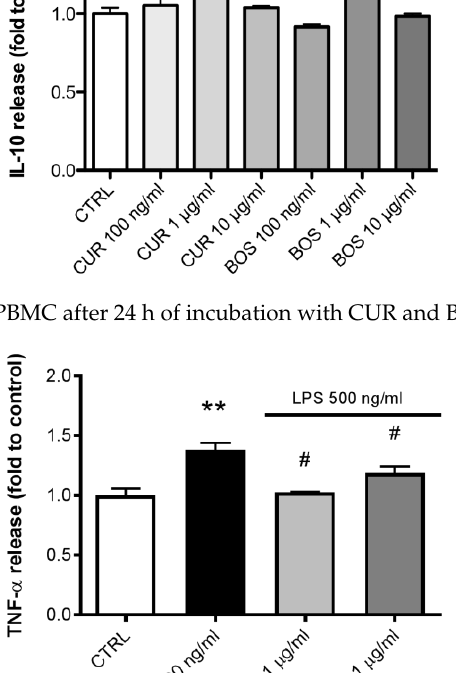
Figure 5. IL-6 release in HMC-1.1 after 24 h of PMA stimulation (50 ng/mL); cells were preincubated with CUR and BOS for 24 h. *** p < 0.001 vs. control; # p < 0.05 vs. stimulus. Neither CUR nor BOS at each of the tested concentrations modulated the release of TNF-α and IL-8 in HMC-1.1 stimulated by PMA (not shown).